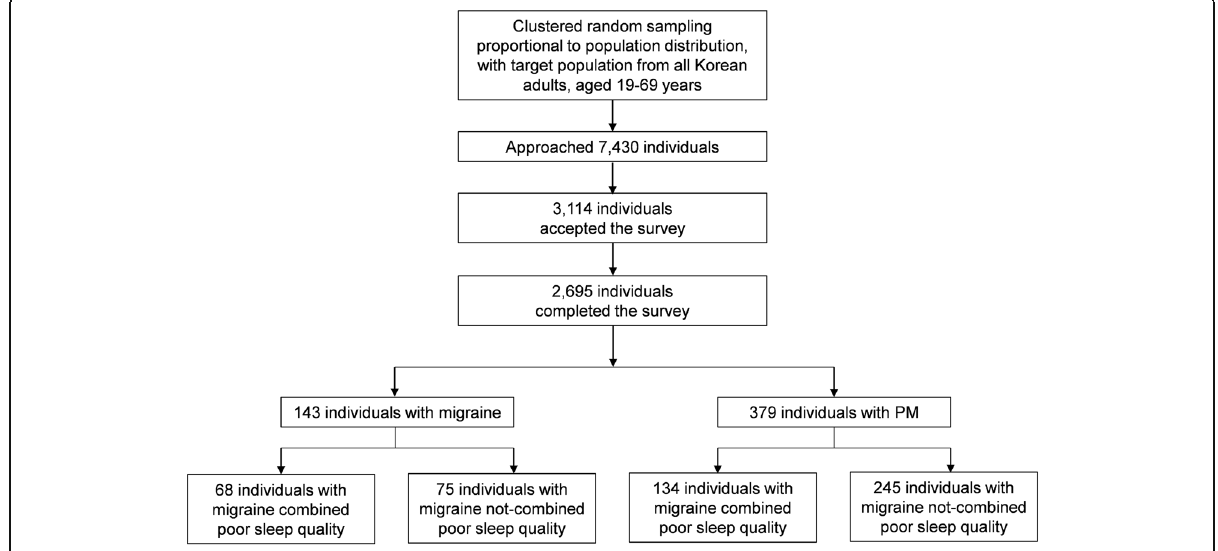
Fig. 1 Flowchart depicting enrolment and participation in the Korean Headache-Sleep